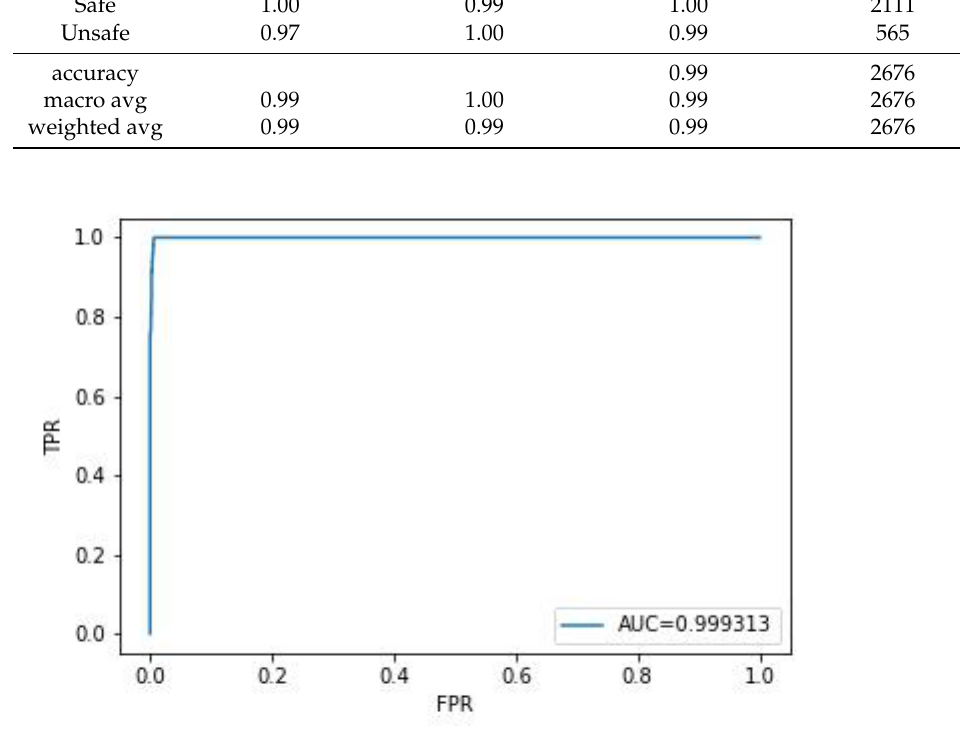
Figure 6. VulEye ROC